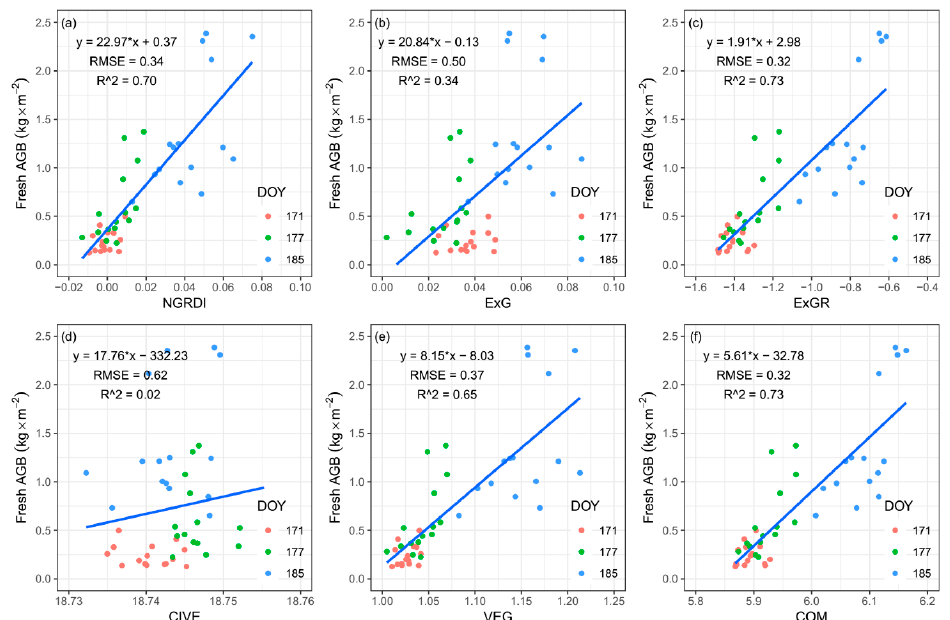
Figure A1. Correlations between five vegetation indices and one VI combination derived from UAV RGB imagery and fresh above-ground biomass (AGB), respectively. ( a ) Normalized green-red di ff erence index (NGRDI); ( b ) excess green index (ExG); ( c ) excess green minus excess red (ExGR); ( d ) color index of vegetation (CIVE); ( e ) vegetation index (VEG); and ( f ) the combination of ExG, ExGR, CIVE and VEG (COM). R 2 represents the coe ffi cient of determination and RMSE represents the root mean square